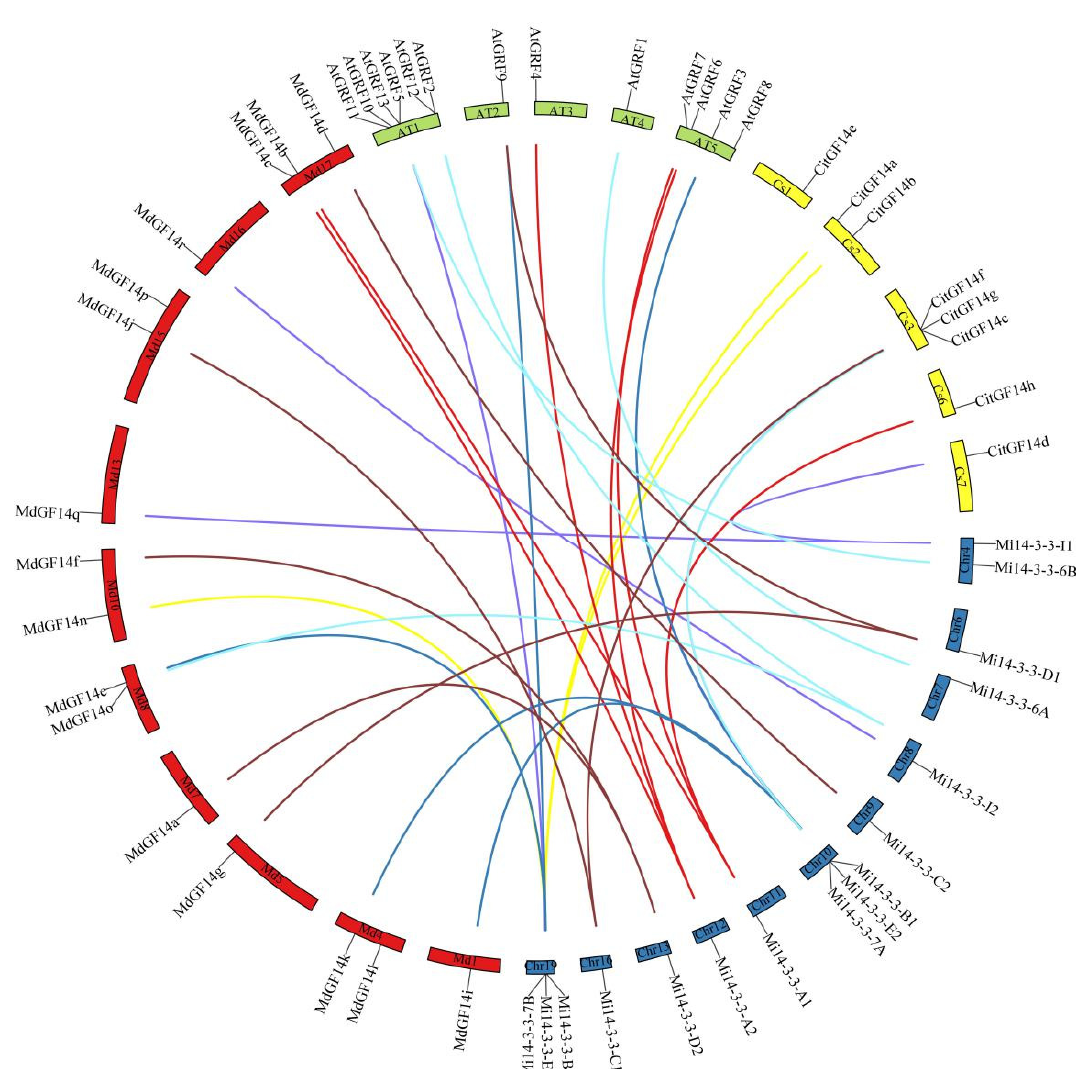
Figure 6. Visualization of the results of an analysis of cis-regulatory elements within the promoters of Mi14-3-3 gene family members.